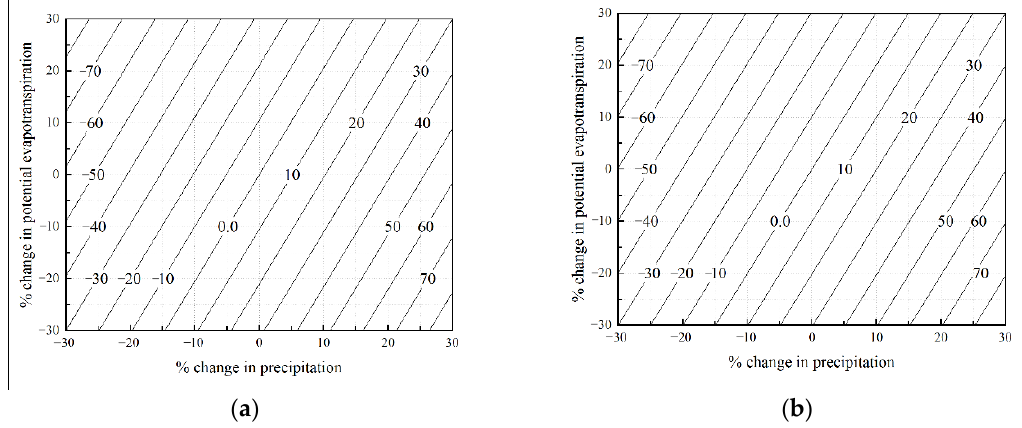
Figure 6. The sensitivity of the runoff ( Q ) to changes in climate ( P , E 0 ): ( a ) % change in the runoff in P1; ( b ) % change in the runoff in P2.